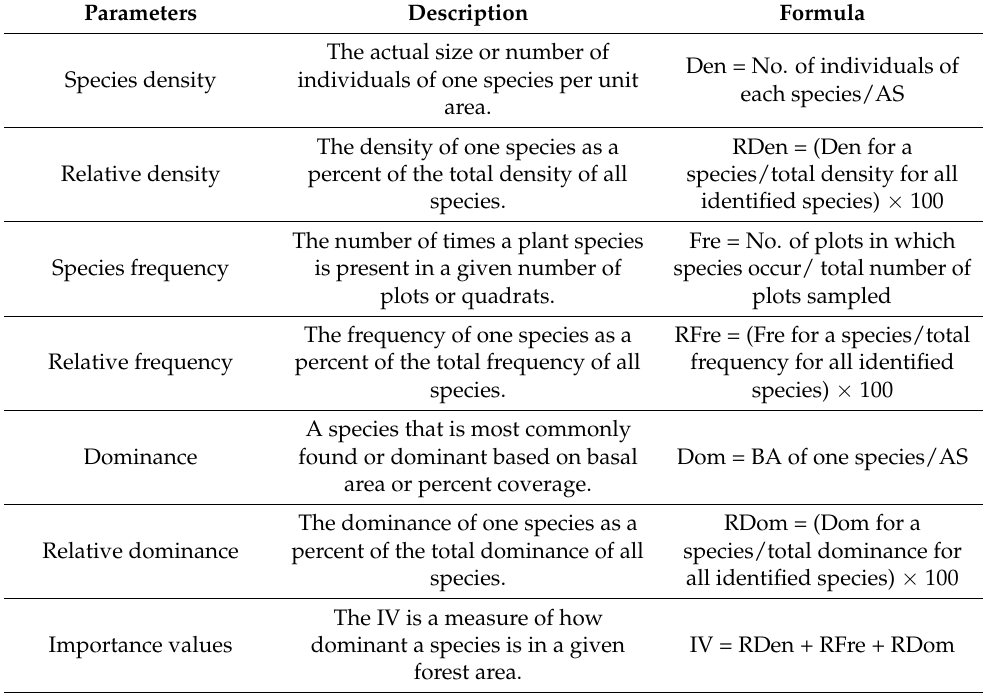
Parameters Description